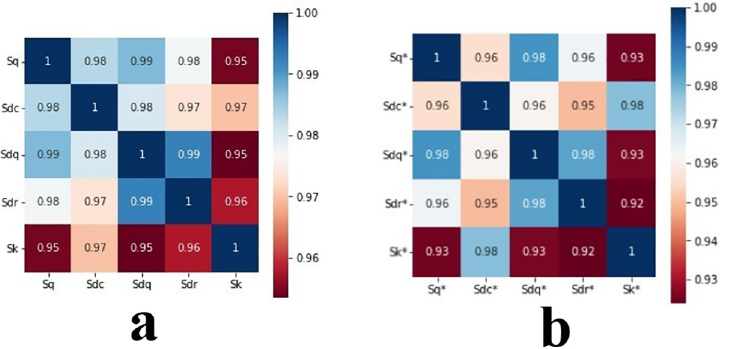
Fig 6. Parameter correlation chart. (a) Correlation before running-in. (b) Correlation after running-in.